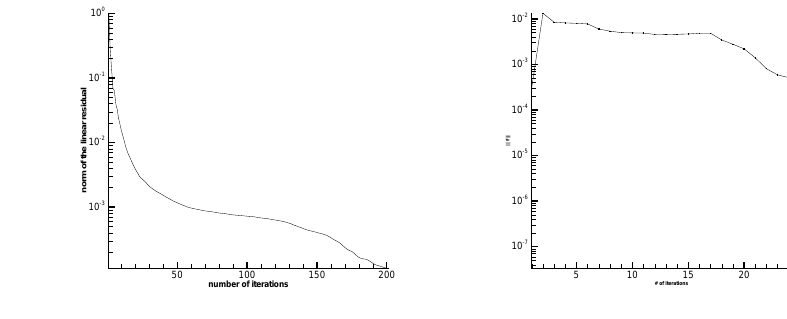
Figure 16. Typical non-linear conver- gence history for Ra = 10 6 .